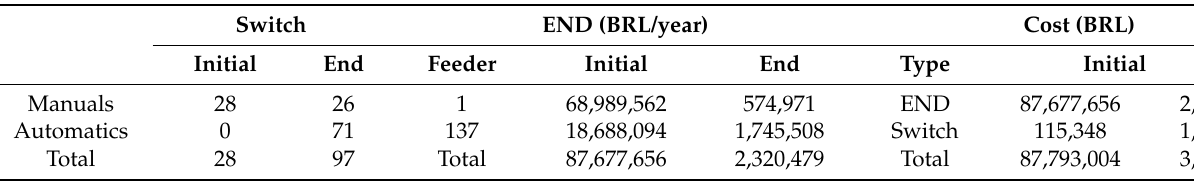
Table 6. Key information and costs for the 136 bars.